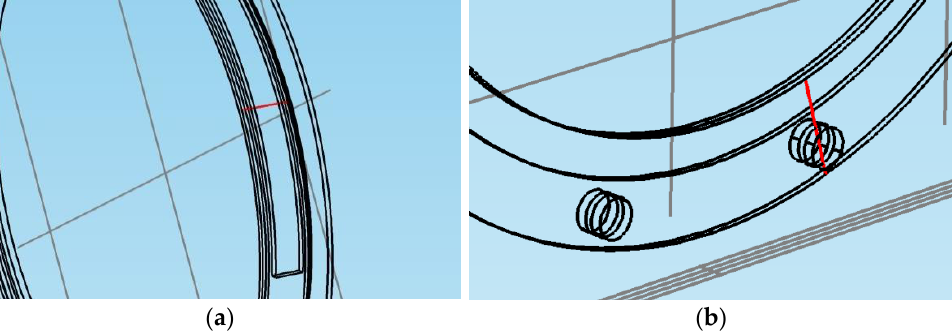
Figure 22. 3D cut line through the fixed and rotational elements for: ( a ) drum-and-shoe brake system; ( b ) disc-and-pads brake system.